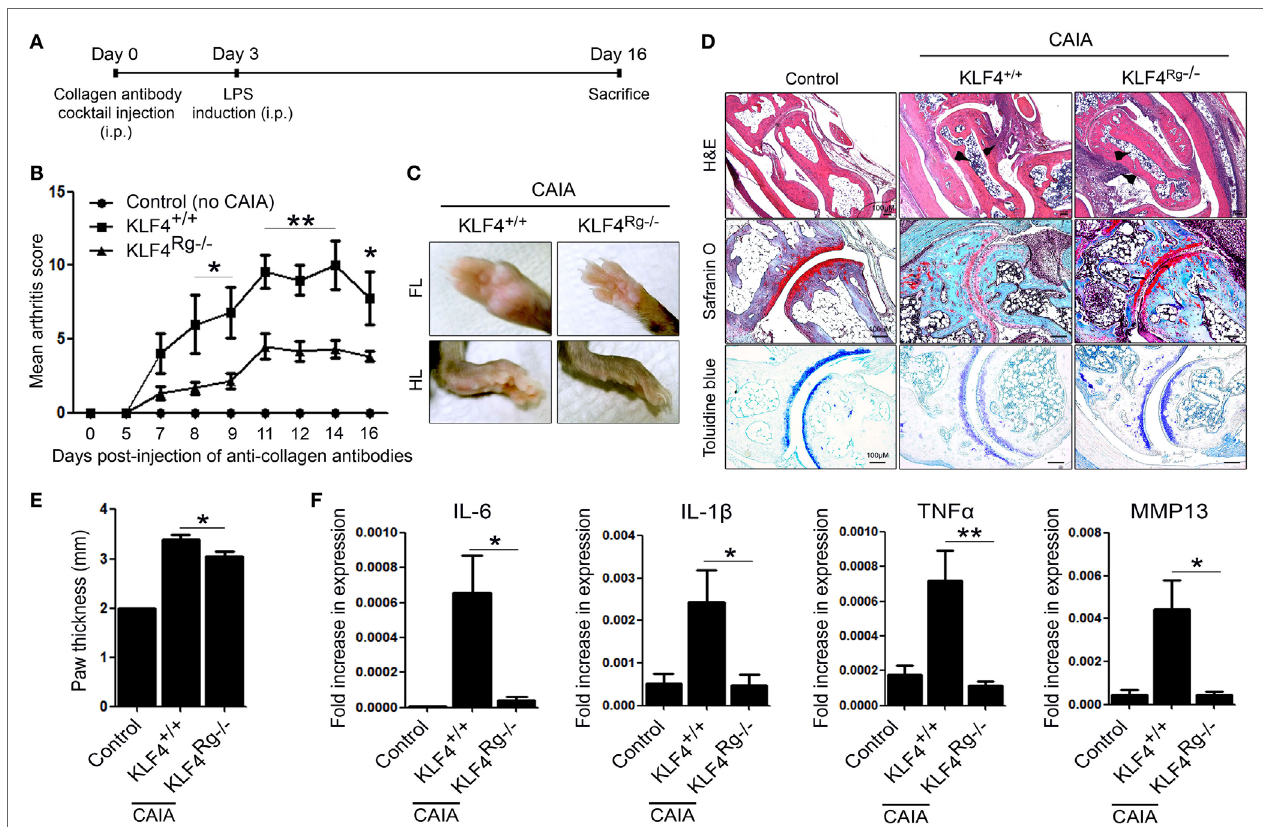
FigUre 2 | The severity of autoimmune-derived inflammation of Kruppel-like factor (KLF) 4 knockout mice is relieved in a collagen antibody-induced arthritis (CAIA) mouse model. (a) Experimental protocol for CAIA induction. (b) Mean arthritis score for control mice (not treated with anti-collagen antibodies) ( n = 3) and for KLF4 + / + ( n = 5) and KLF4 Rg − / − ( n = 6) mice (treated with anti-collagen antibodies). (c) Forelimbs (FL) and hindlimbs (HLs) of collagen antibody-treated KLF4 + / + and KLF4 Rg − / − mice. (D,e) Immunohistochemical staining and paw thickness of HL from control, KLF4 + / + , and KLF4 Rg − / − mice. Tissues were stained with hematoxylin and eosin (H&E), Safranin O, and Toluidine blue. Cellular infiltration is pointed by arrow heads. Data are representative of at least five replicates of the staining per each group. Original magnification: H&E, 50 × ; Safranin O and Toluidine blue, 100 × . (F) Expression of mRNA encoding IL-6, interleukin (IL)-1 β , tumor necrosis factor-alpha (TNF- α ), and matrix metallopeptidase 13 (MMP13) in paw cells. Values in panels (b,e,F) are expressed as the mean ± SEM (* P < 0.05, ** P < 0.01, and *** P <